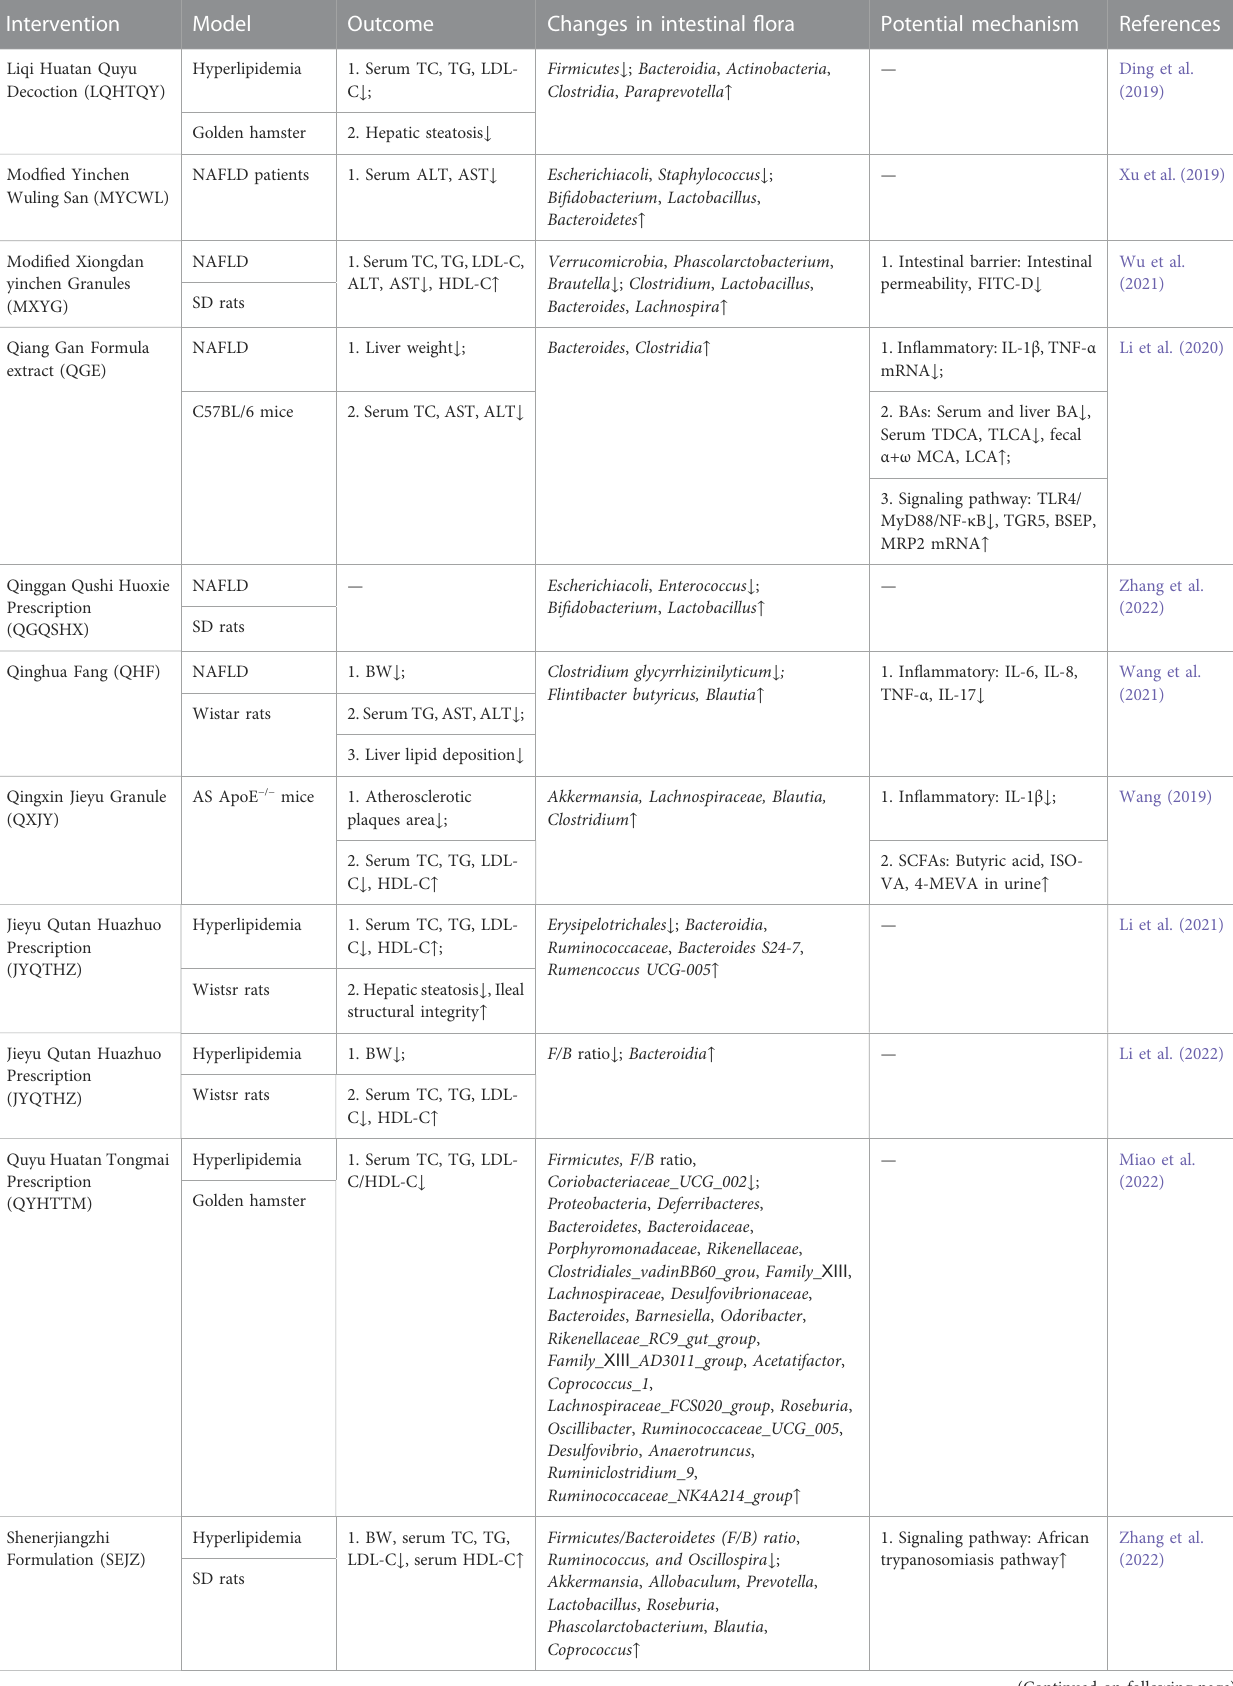
TABLE 1 ( Continued ) Therapeutic effects of Chinese herbal formulas and proprietary Chinese medicines on